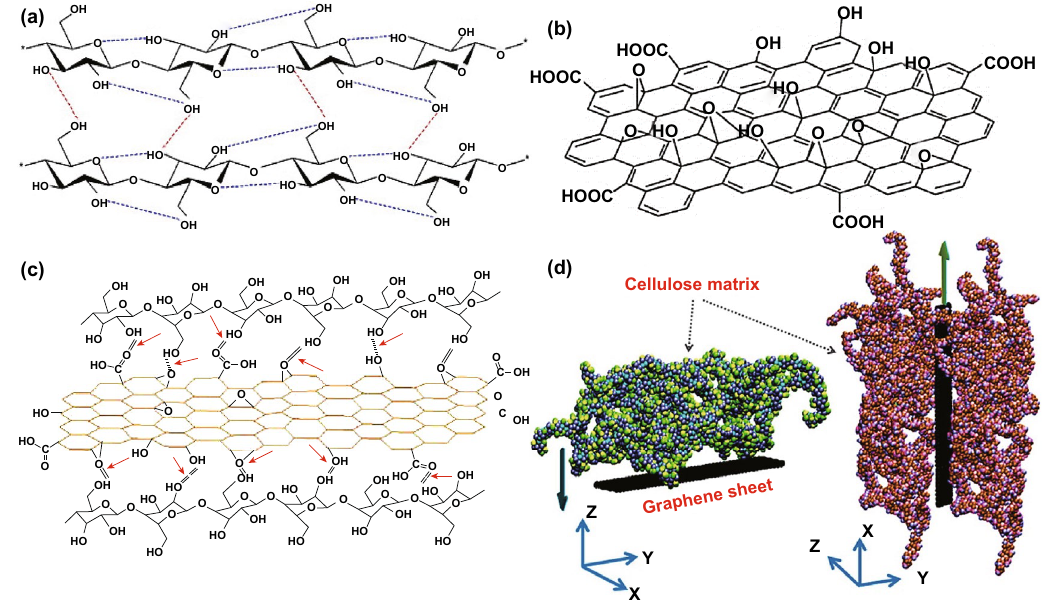
Fig. 5 a NCs intra-intermolecular hydrogen bonding networks. Reproduced with permission from Ref. [102] Copyright 2018, Elsevier. b Gra- phene oxide proposed a structural model. Reproduced with permission from Ref. [104] Copyright © 2015, The Royal Society of Chemistry. c Schematic illustration of the hydrogen bonding (red rows) of regenerated GO nanosheets and NCs molecular chains. Reproduced with permis- sion from Ref. [105] Copyright © 2012, Chinese Materials Research Society, Production and hosting by Elsevier B.V. d Model of the interfacial interactions between the graphene sheet and cellulose chain matrix. Reproduced with permission from Ref. [107] Copyright © 2013, American Chemical